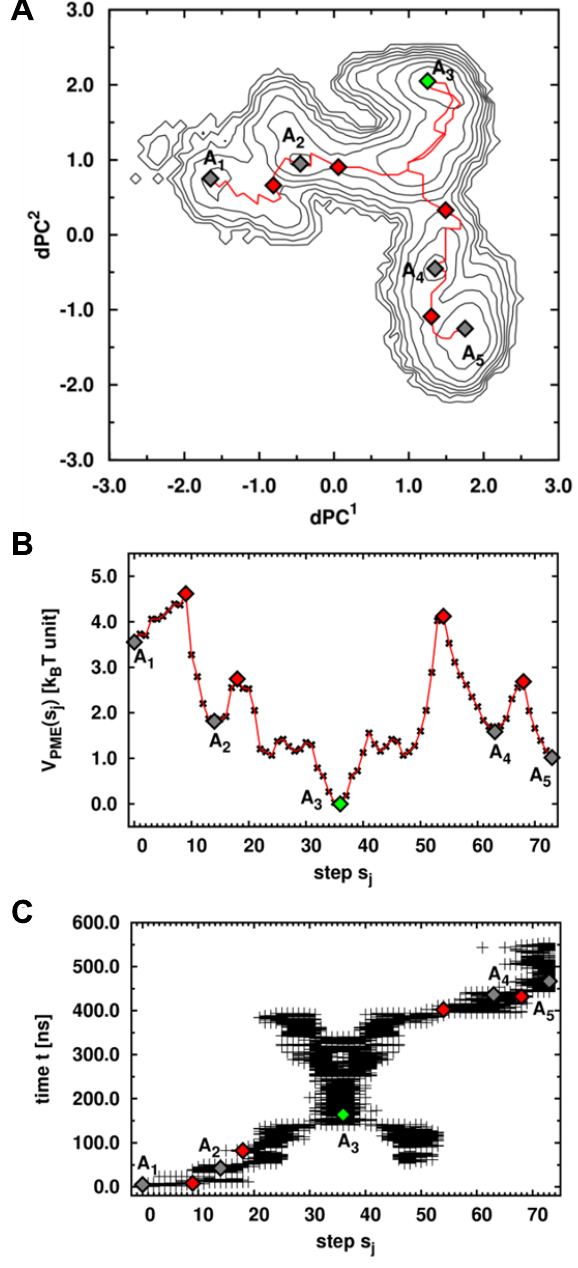
Figure 9. Analysis of the FEL of ATP-bound DnaK. A: FES generated from dPCA of MD run ATP1. Minima and saddle points are shown with gray (green for the most probable one) and red diamonds, respectively. The PME is represented by the red line. B: Free-energy V PME along the PME for the transition A 1 R A 2 R A 3 R A 4 R A 5 . C: Results of the clustering along the PME. Each frame is represented at the correspond- ing time t observed in the MD trajectory.